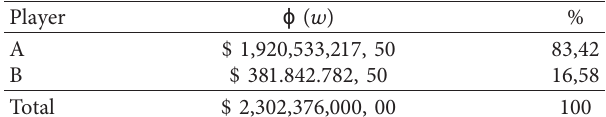
Table 5: Calculation of the Shapley value ($ COP and percentage) for each of the players.